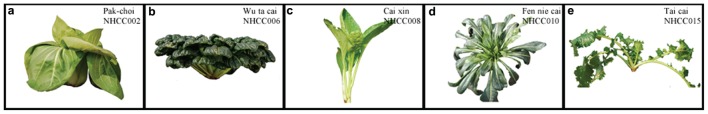
The five morphotypes of Brassica rapa ssp. chinensis. (a) Pak-choi; (b) Wu ta cai; (c) Cai xin; (d) Fen nie cai; (e) Tai cai.